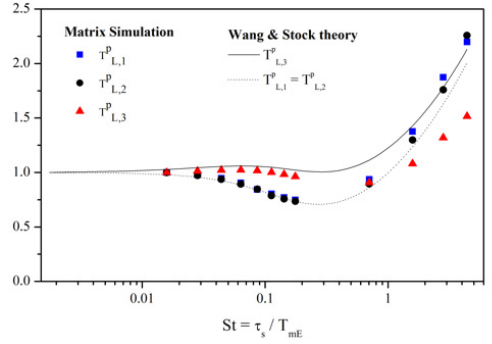
Figure 23. Particle Lagrangian time scale (g ≠ 0).